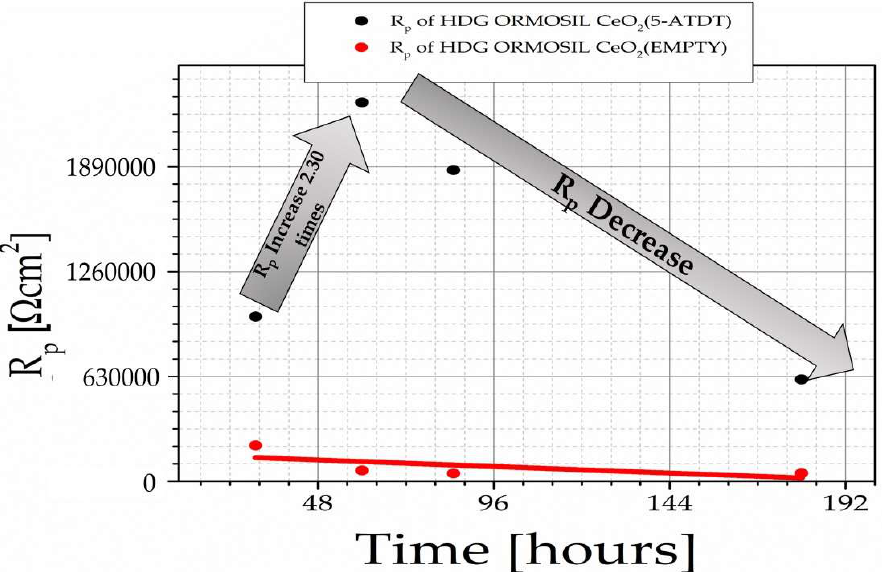
Figure 6. R p of HDG-ORMOSIL + CeO 2 (EMPTY) and HDG-ORMOSIL + CeO 2 (5-ATDT) function of exposure to the salt solution.